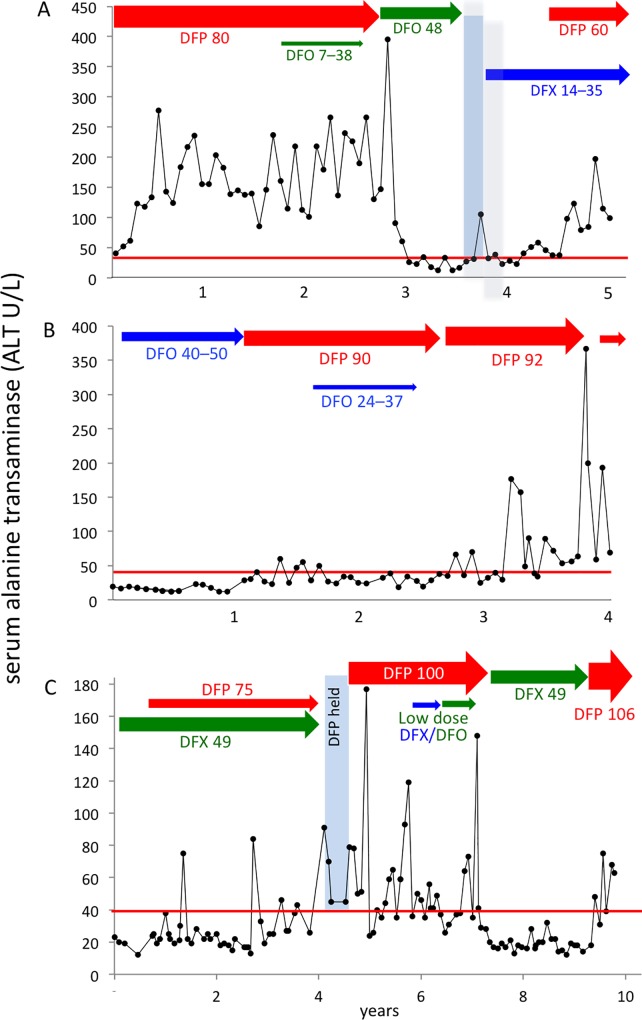
ALT elevations correlating with deferiprone chelation.(A) Patient #34, (B) Patient #1, (C) Patient #19 (datafile). Normal ALT <40U/L, red line; deferiprone (DFP) red arrows and font; deferasirox (DFX), blue arrows and font; deferoxamine (DFO), green arrows and font.